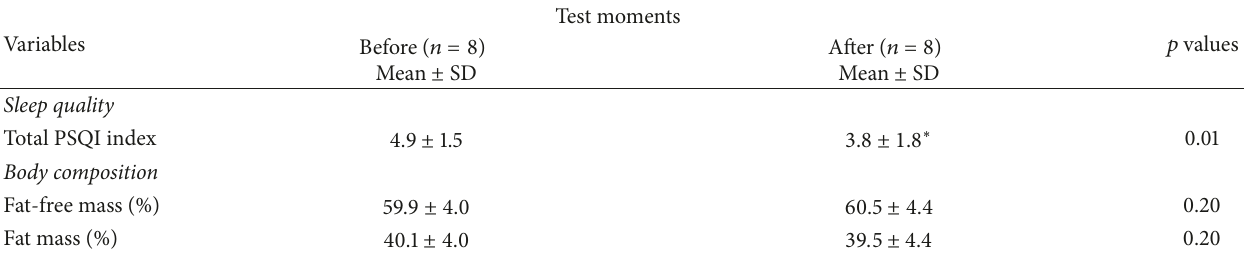
Table 1: Sleep quality and body composition before (in baseline) and after 8 weeks of a dynamic combined training program (𝑛 = 8) .